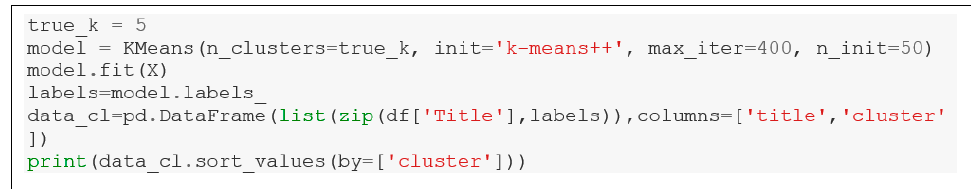
Figure 9. Code 6: Applying K-Means, own elaboration.